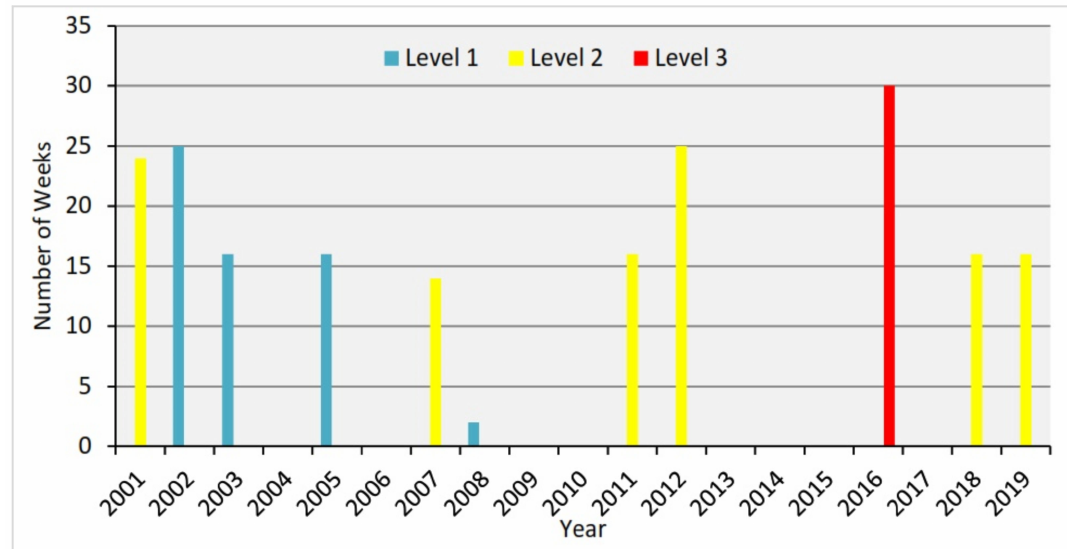
Figure 18. Low water events in the study area from 2001 to 2019 (based on the records of the Ontario Ministry of Natural Resources and Forestry (MNRF)). Adopted from Ref.